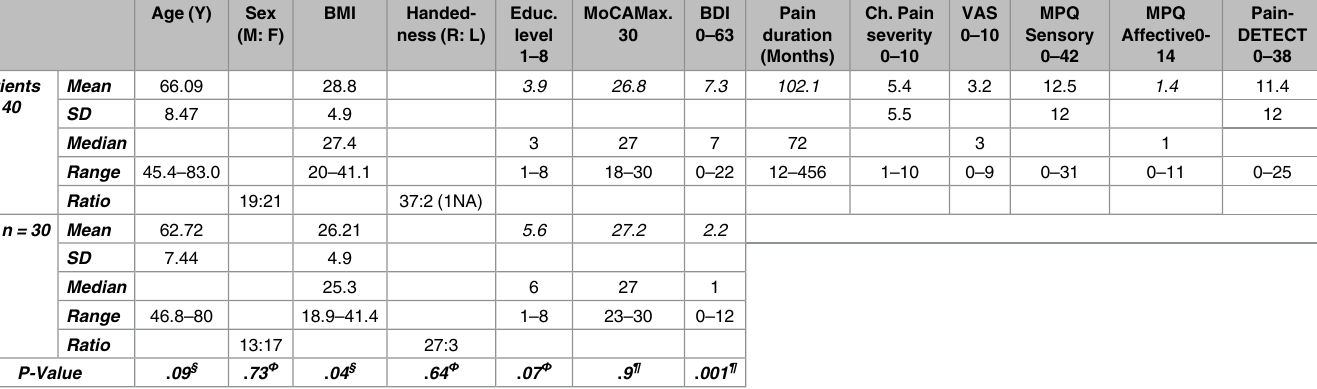
the painful knee. The average of the last two readings for the three non-local sites was used to indicate non-knee or remote PPT, and those from knee joint lines to indicate knee or local PPT. Cognitive ability of all participants was evaluated during a face-to-face interview